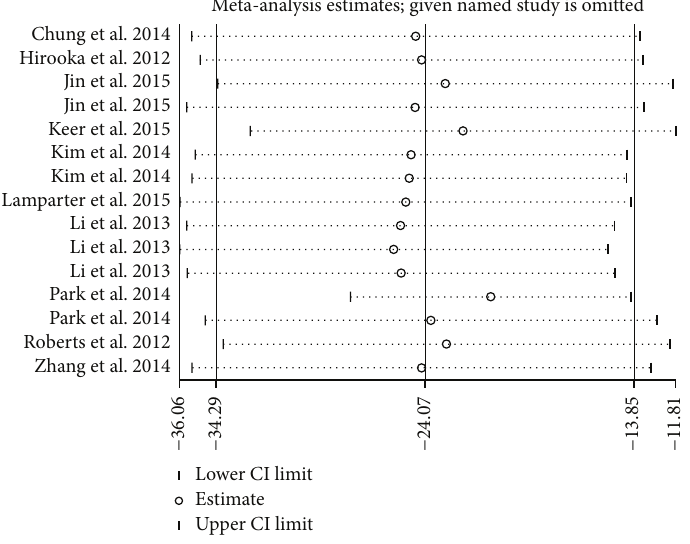
Figure 5: Sensitivity analysis of average PPCT. CI indicates confidence